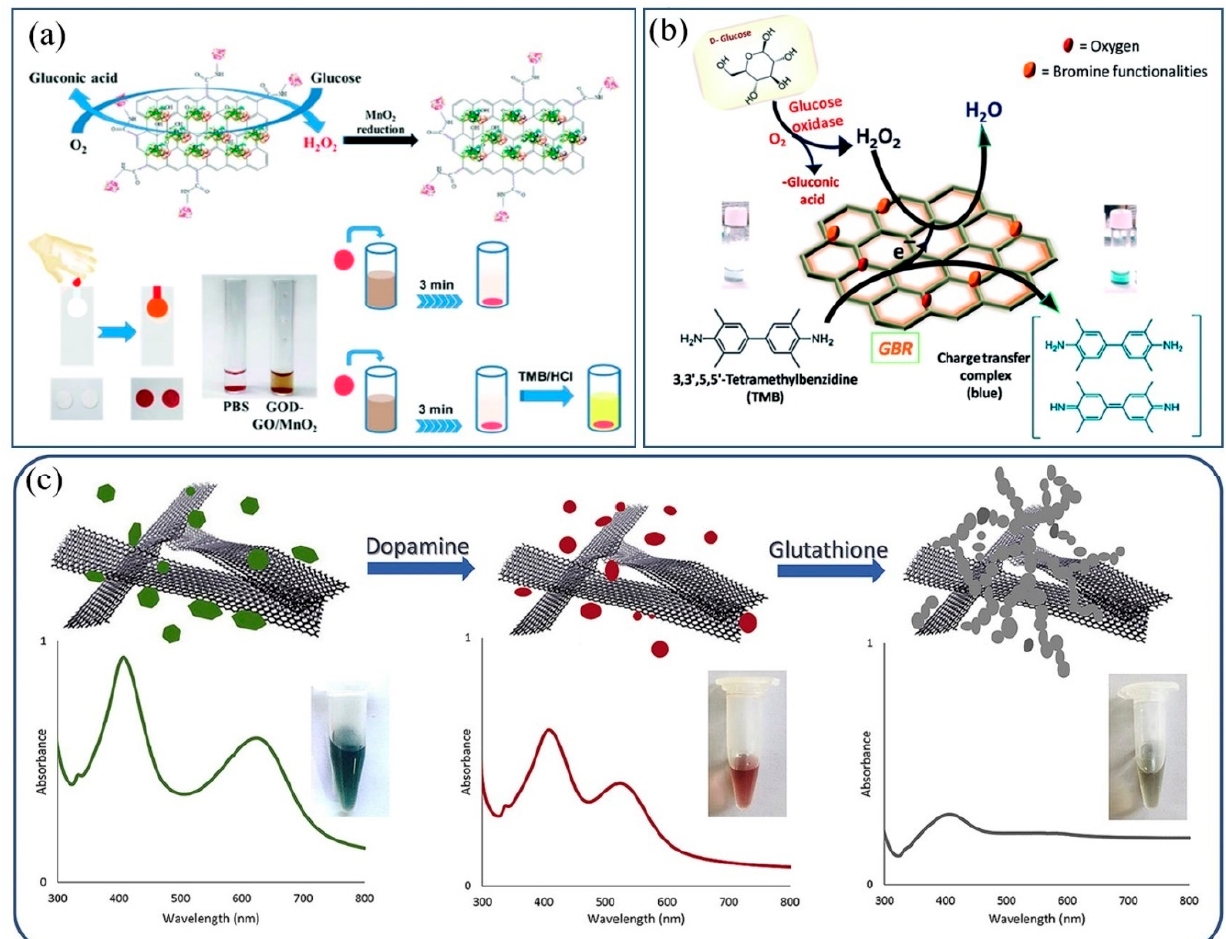
Figure 7. Colorimetric sensing of small molecules with 2D materials: ( a ) oxidase-graphene oxide/manganese dioxide (GOD-GO/MnO 2 ) direct colorimetric determination of glucose concentration. Reprinted with permission from Ref. [74], Copyright 2019, Royal Society of Chemistry. ( b ) Plausible mechanism of glucose detection. Reprinted with permission from Ref. [75], Copyright 2017, Royal Society of Chemistry. ( c ) Graphene/silver hybrid material colorimetric detection of dopamine (DA) and glutathione (GSH). Reprinted with permission from Ref. [22], Copyright 2020, Elsevier.